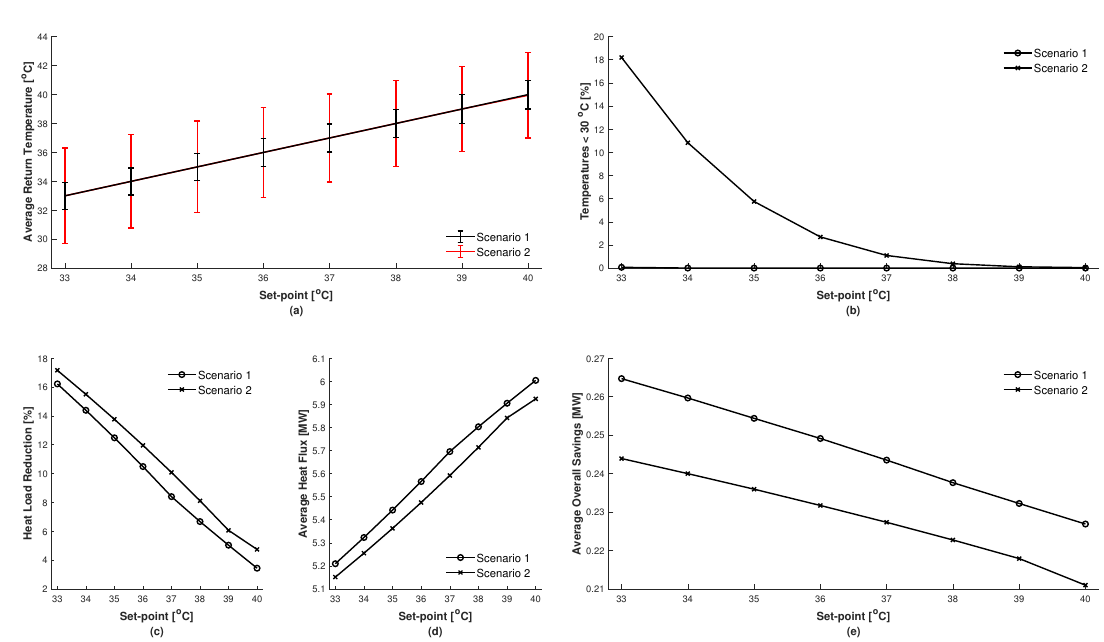
Figure 9. Sensitivity test from varying the set-point on the return temperature for each scenario: ( a ) average return temperature, ( b ) percentage of temperatures occurring below 30 ◦ C, ( c ) potential percentage in heat load reduction, ( d ) average rate of heat supplied, and ( e ) average overall savings